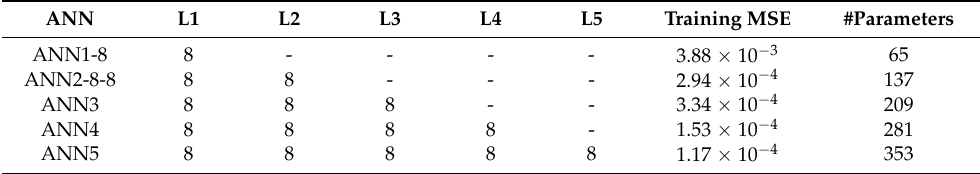
Table A2. Multi-layer ANN training results comparison.